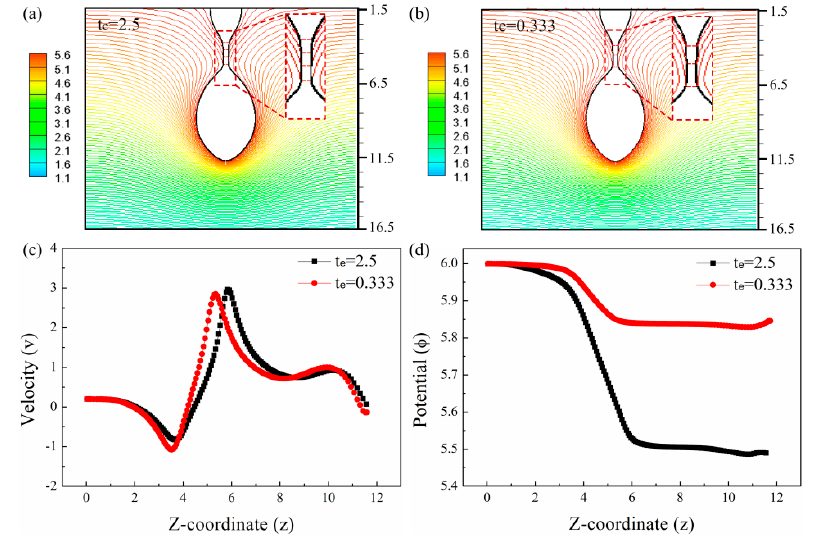
Figure 6. The isopotential lines at the instant when t = 0 for liquid with CRT of ( a ) t e = 2.5 and ( b ) t e = 0.333. ( c ) The velocity distribution for liquids with different CRTs at the instant when t = 0. ( d ) The potential distribution for liquids with different CRTs at the instant when t = 0. The other parameters of the liquids are ε r = 50, Oh = 0.05, φ = 6, Q s =